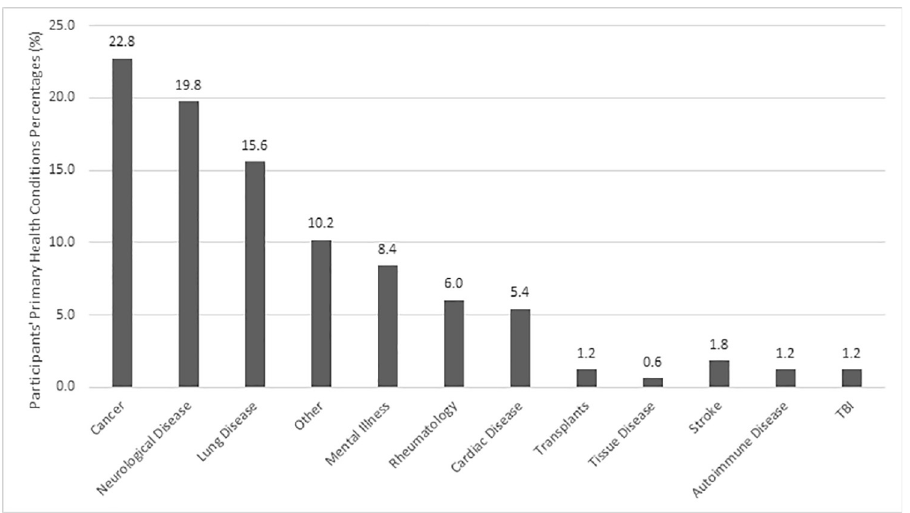
Fig 1. Participants’ primary health condition percentages (grouped by disease